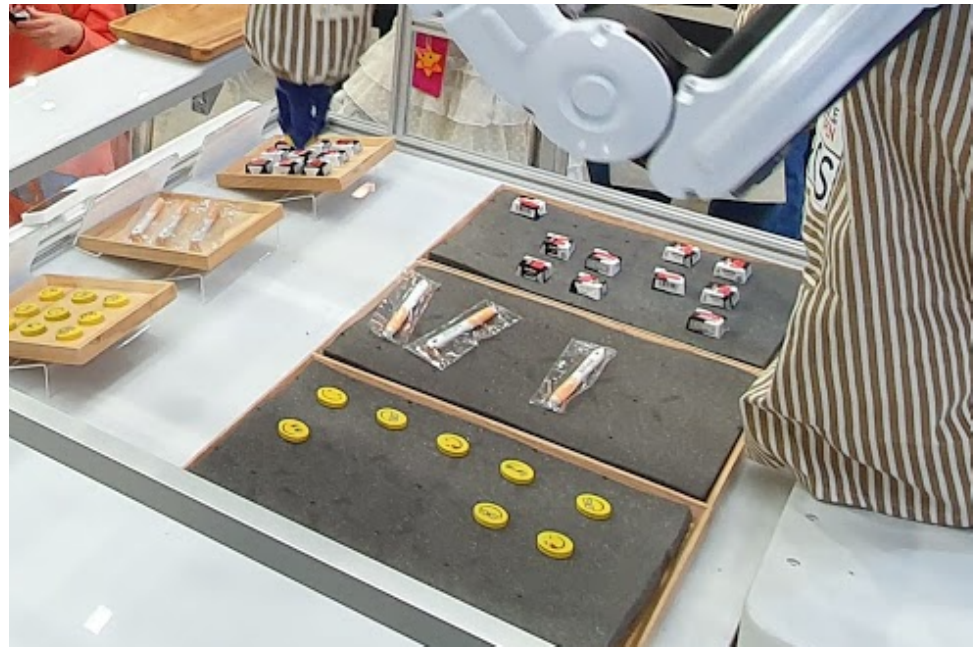
Figure 4. Real scene with the objects the robot has to detect and